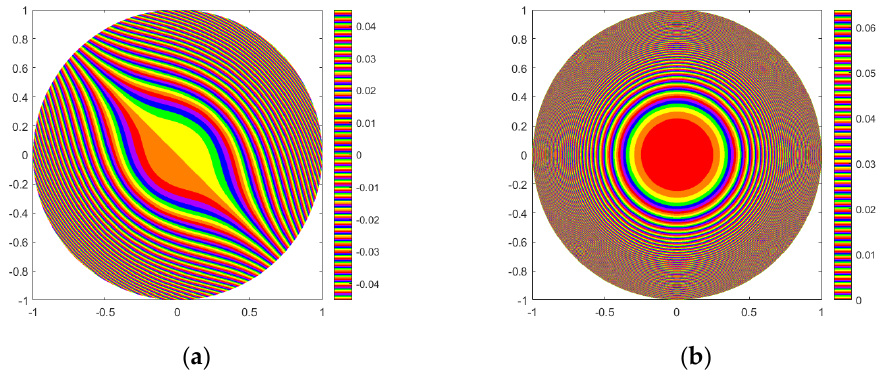
Figure 4. The spherical aberrations ( a ) and coma ( b ) map fitted by Zernike polynomials.